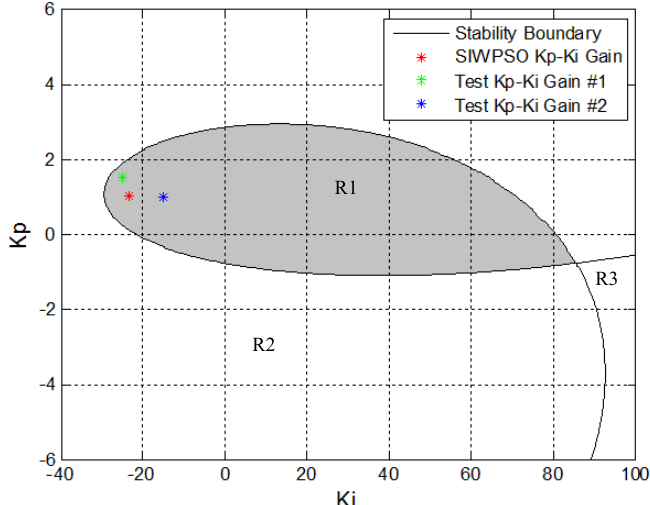
Figure 13. Stability regions of PID controller for Equation